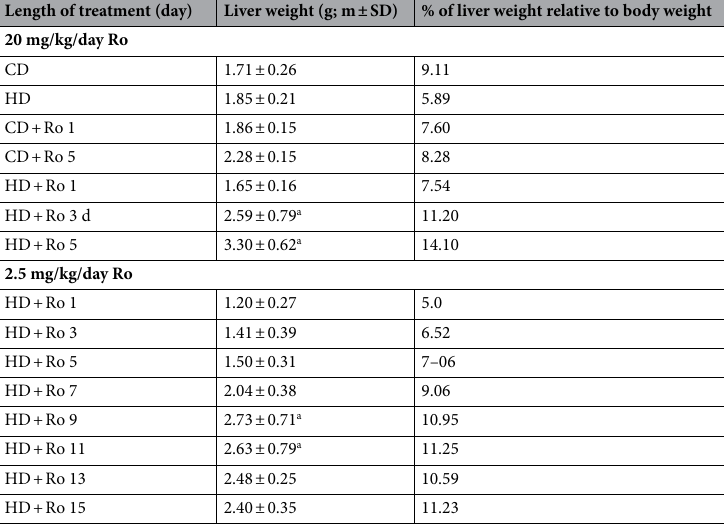
Table 4. Liver weight and its relation to body weight in hypercholesterolemic mice treated with 20 and 2.5 mg/kg/day of rosuvastatin, after days of treatment. CD control diet; HD hypercholesterolemic diet; Ro rosuvastatin 20 mg/kg/day; Ro rosuvastatin 2.5 mg/kg/day, M media, SD standard deviation. a Key of significance compared with HD ( p <